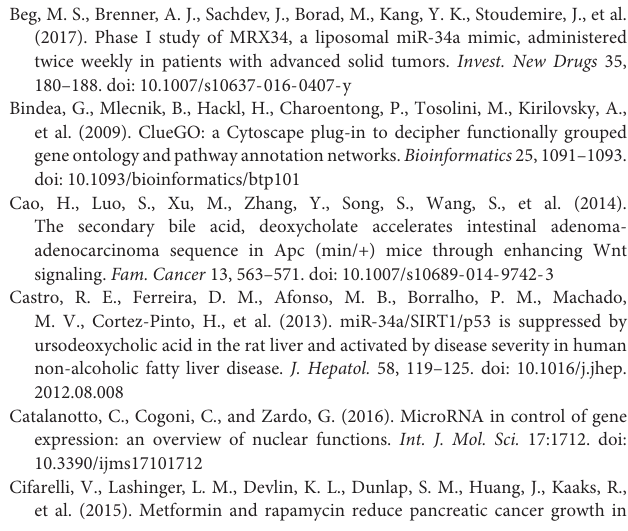
FIGURE S1 | The workflow of the methodology used in the study. miRNA(s), micro-RNA(s); TF(s), transcription factor(s); CRA, colorectal adenoma; CRC, colorectal cancer; DEGs a , differentially expressed genes found in the comparison CRA samples versus normal samples; DEMs a , differentially expressed miRNA found in the comparison CRA samples versus normal samples; DEGs b , differentially expressed genes found in the comparison CRC samples versus CRA samples; DEMs b , differentially expressed miRNA found in the comparison CRC samples versus CRA samples. FIGURE S2 | Protein–protein interaction (PPI) network conducted based on 514 DEGs between CRA and normal tissues. Red nodes and green nodes indicate upregulated and downregulated genes, respectively. Diamond nodes represent the identified hub genes. PPI, protein-protein interaction; DEGs, differentially expressed genes; CRA, colorectal adenoma. FIGURE S3 | Regulatory network of DEMs and their target DEGs in the comparison CRC samples versus CRA samples. Red nodes and green nodes indicate upregulated genes/miRNAs and downregulated genes/miRNAs, respectively. Triangles represent DEMs and circles represent target DEGs. miRNAs, microRNAs; DEMs, differentially expressed miRNAs; DEGs, differentially expressed genes; CRA, colorectal adenoma; CRC, colorectal cancer. TABLE S1 | Differentially expressed genes between CRA tissues and normal tissues identified from GSE31905, GSE4183, GSE37364, and GSE41657. CRA, colorectal adenoma. TABLE S2 | Regulatory networks of the key miRNAs, target genes and transcription factors. miRNAs,